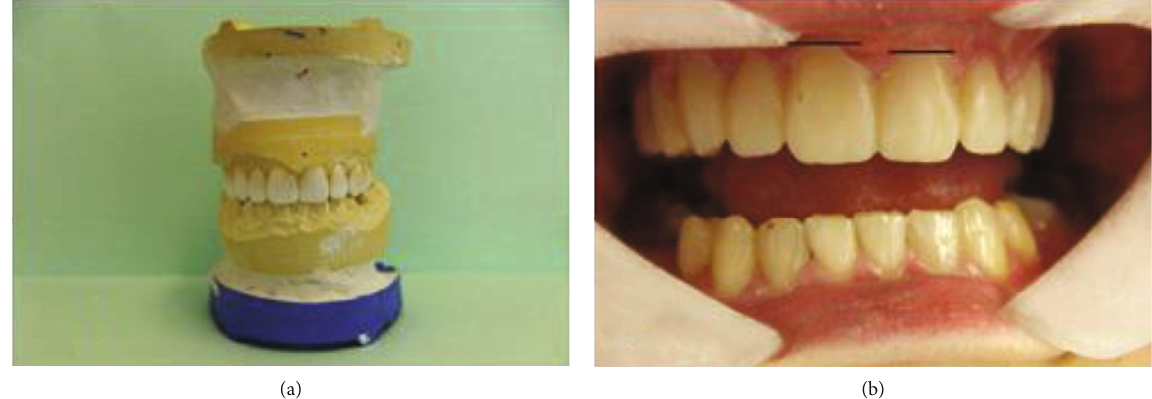
Figure 5: (a) Wax-up of maxillary arch. (b) Mock-up of maxillary arch, new occlusion was tested for over a